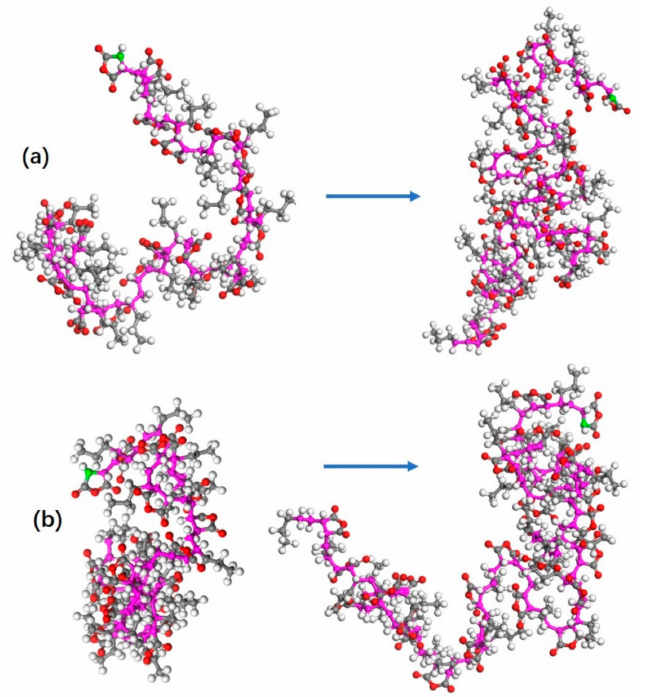
Figure 6. The molecular conformation evolution of 1-pentene–maleic anhydride (1PM) in the acetone as a solvent ( a ) and ethyl acetate as a solvent ( b ). The green atom is the active center, and degree of polymerization (DP) is 20 and 30 from left to right, respectively.